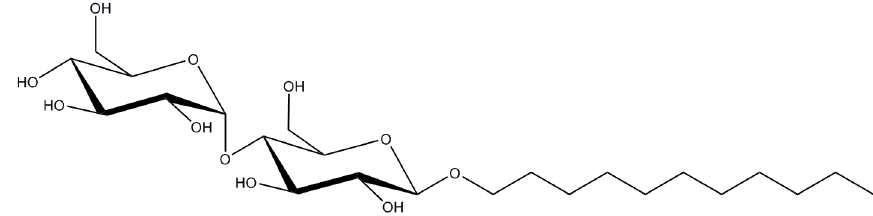
Figure 9. Structure of n-Undecyl- β - D -maltopyranoside (UDM) (chemical formula is C 23 H 44 O 11 ).